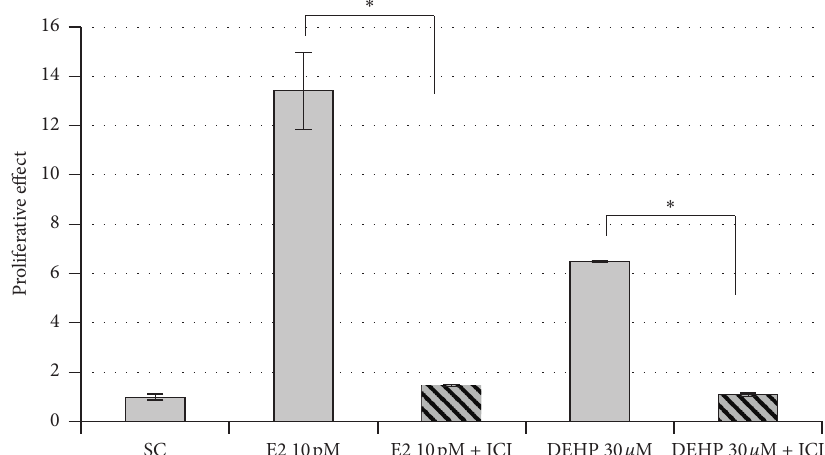
Figure 2: E-Screen agonist competitive confirmation assay for DEHP. MCF-7 cells were exposed for 120h to DEHP 30 μ M with or without the reference antiestrogen ICI 182,780 (ICI). E210pM was used as reference estrogenic control. ∗ Statistically significant decrease compared to the proliferation without ICI ( p ≤ 0 . 05).